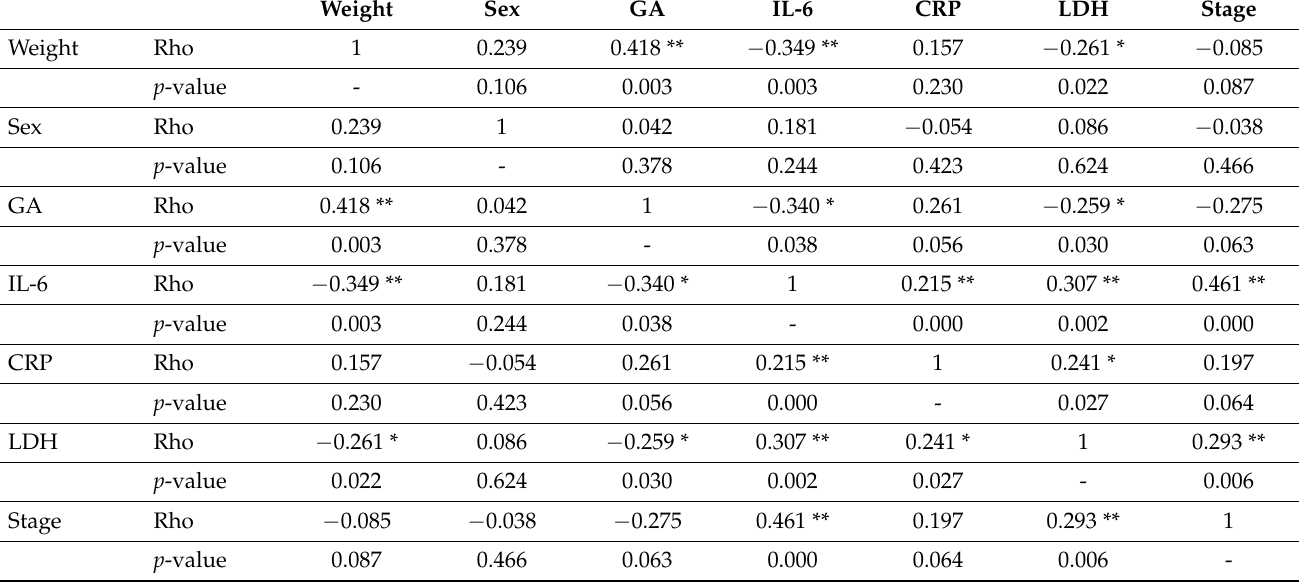
Table 5. Correlation analysis of the studied